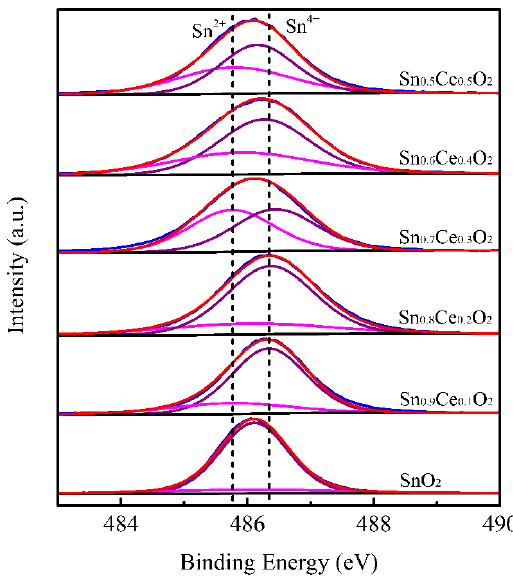
Figure 9. XPS spectra in the Sn 3d 5/2 region of the SnO 2 and Sn x Ce 1-x O 2 fiber catalysts. Table 2. XPS parameters for Sn, Ce, and O of the SnO 2 and Sn x Ce 1 − x O 2 fiber catalysts. Fiber Catalysts